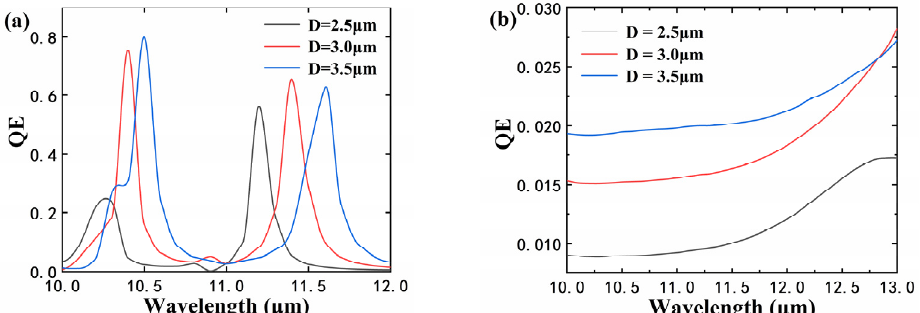
Figure 7. ( a ) QE as a function of incident wavelength at different micropillar diameters (D). The substrate is removed, and cavity effects appear by tuning the device sizes, so the peak QE is a remarkable value for QWIP. ( b ) QE as a function of incident wavelength at different micropillar diameters (D). For comparison, a thick substrate is added to the simulation in this figure. The device exhibits a very low QE due to the absence of cavity effects. h_ab and h_public are set to be the optimal value of 1.705 μ m and 1.65 μ m, respectively.